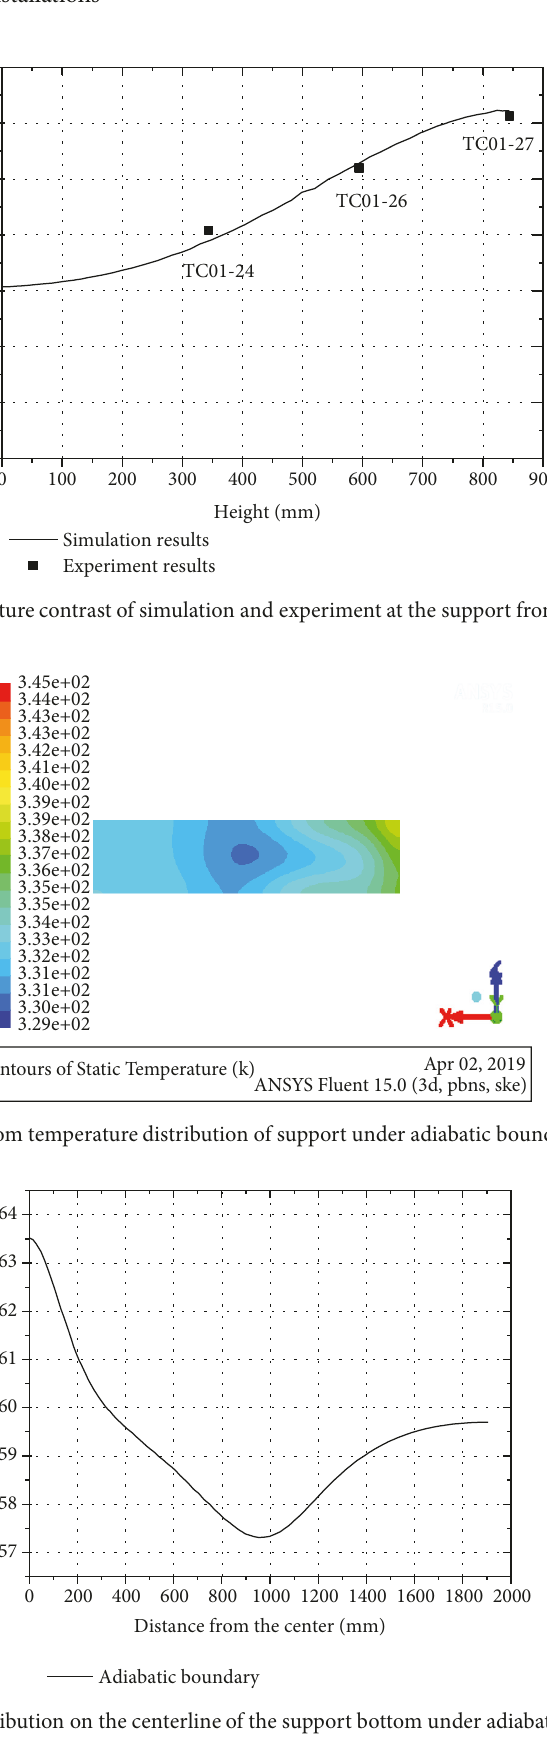
Figure 31: Temperature distribution on the centerline of the support bottom under adiabatic boundary